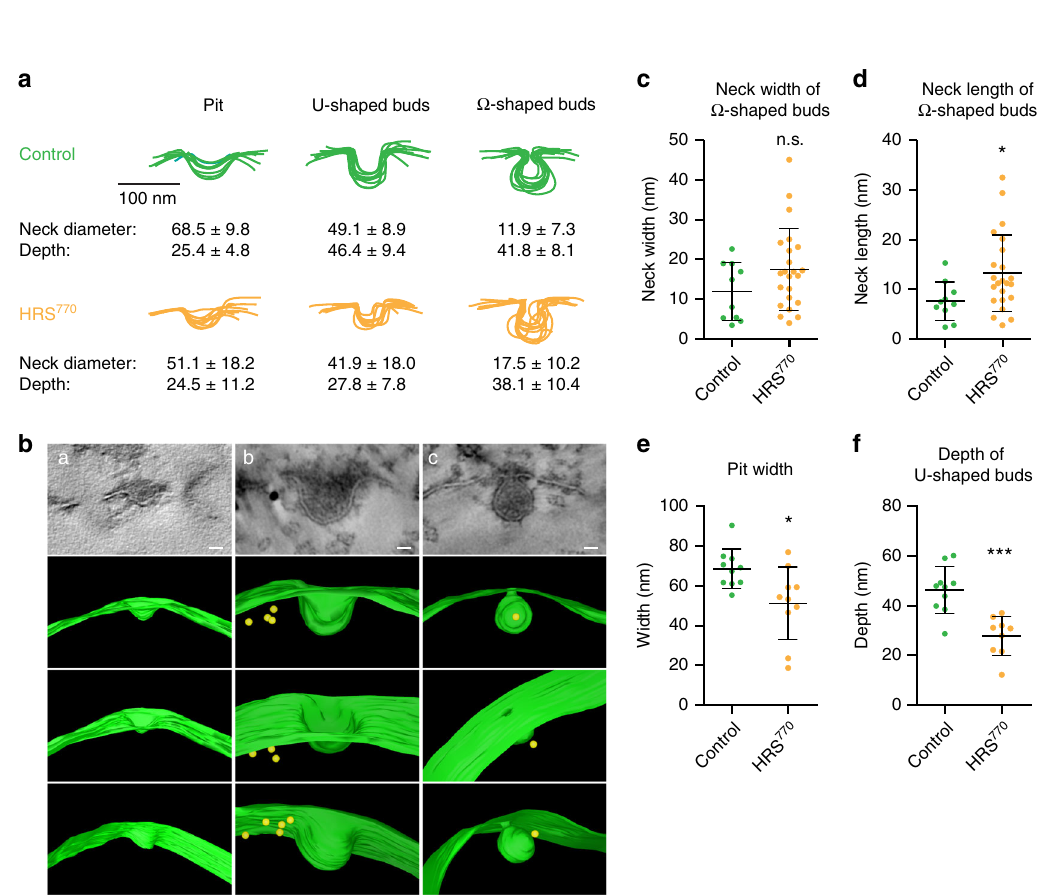
Fig. 8 The absence of clathrin at endosomes results in aberrant ILV formation. a Budding pro fi les as observed in electron micrographs were binned into three morphological categories: Pits, U-shaped buds and omega-shaped buds (see also Supplementary Fig. 8). The outlines of these budding pro fi les were aligned with each other to assess their uniformity. Upper row: budding pro fi les from the control dataset. Lower row: budding pro fi les from the siHRS/ HRS 770 dataset. In all, 9 – 10 pro fi les per category and condition were used for superimposition. Neck diameter and depth were measured on all displayed pro fi les and their average ± SD is indicated. b Tomograms showing examples of every budding pro fi le category. Scale bar, 20 nm. c Neck width of Omega- shaped buds represented as dot plot. Mean± SD. t -test, n.s. not statistically signi fi cant. d Neck length of Omega-shaped buds represented as dot plot. Mean± SD. t -test, * p < 0.05. e Pit width represented as dot plot. Mean ± SD. t -test, * p < 0.05. f Depth of U-shaped budding pro fi les represented as dot plot. Mean± SD. t- test, *** p <